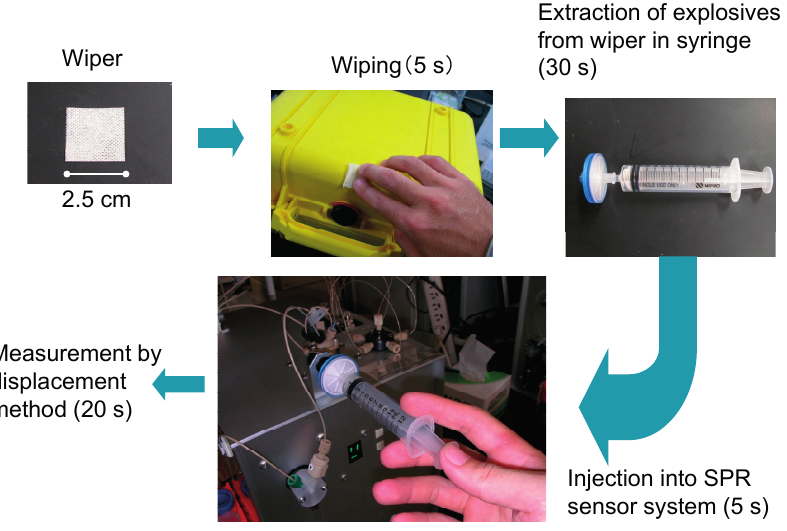
Figure 14. Procedure of wiping method